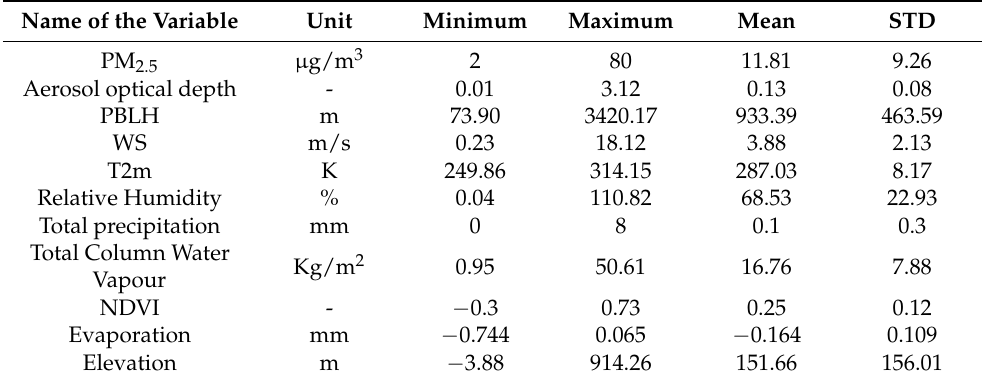
Table 1. The dependent and independent variables used to build the ET